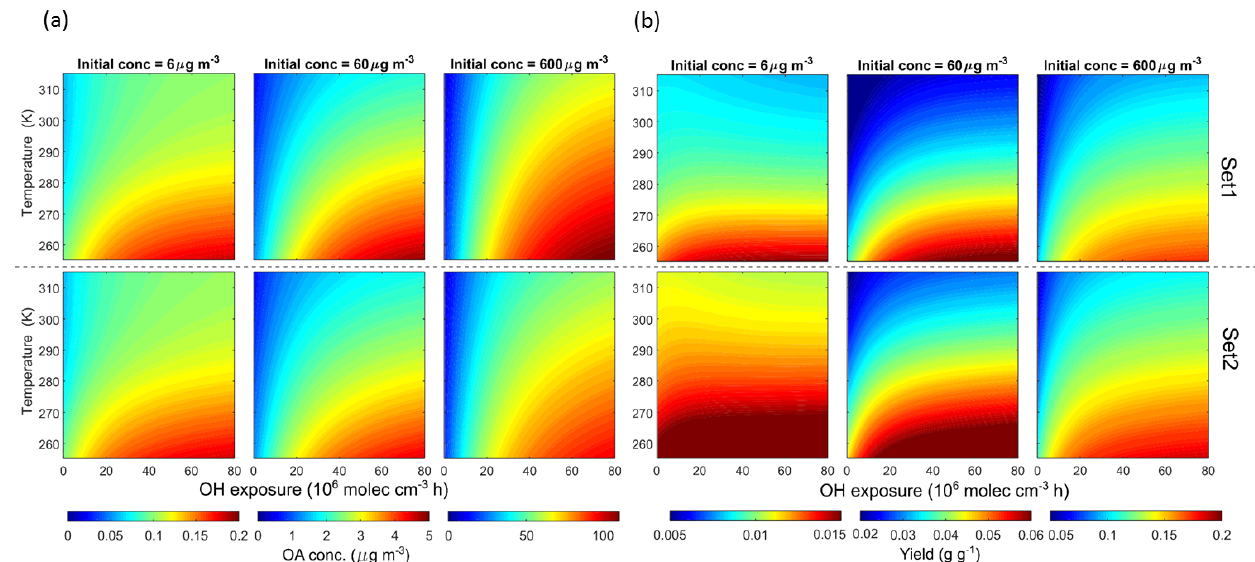
Figure 10. Modelled OA concentrations (a) and yields (b) under different temperature, OH exposure and initial OA concentrations (6, 60 and 600µgm − 3 ). Upper and lower panels are based on Set 1 and Set 2, respectively. Temperature is provided in kelvin (K) to avoid confusion with the experimental data in degrees Celsius ( ◦